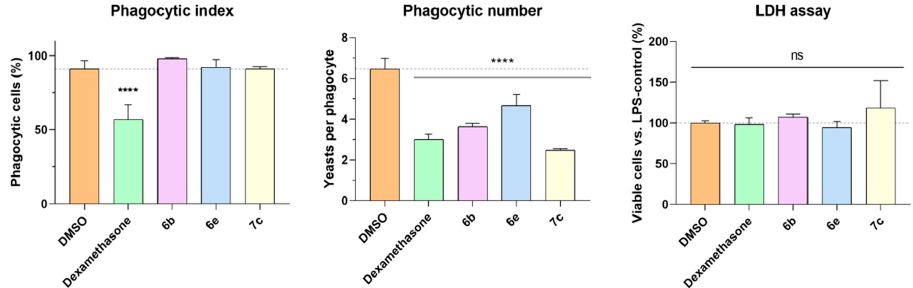
Figure 1. Effect of compounds on phagocytic activity and viability of C57bl/6j peritoneal macrophages. Data are shown as mean and 95% C.I. ( n = 100); **** p < 0.0001 vs. DMSO (1-way ANOVA with Dunnett’s post-test).